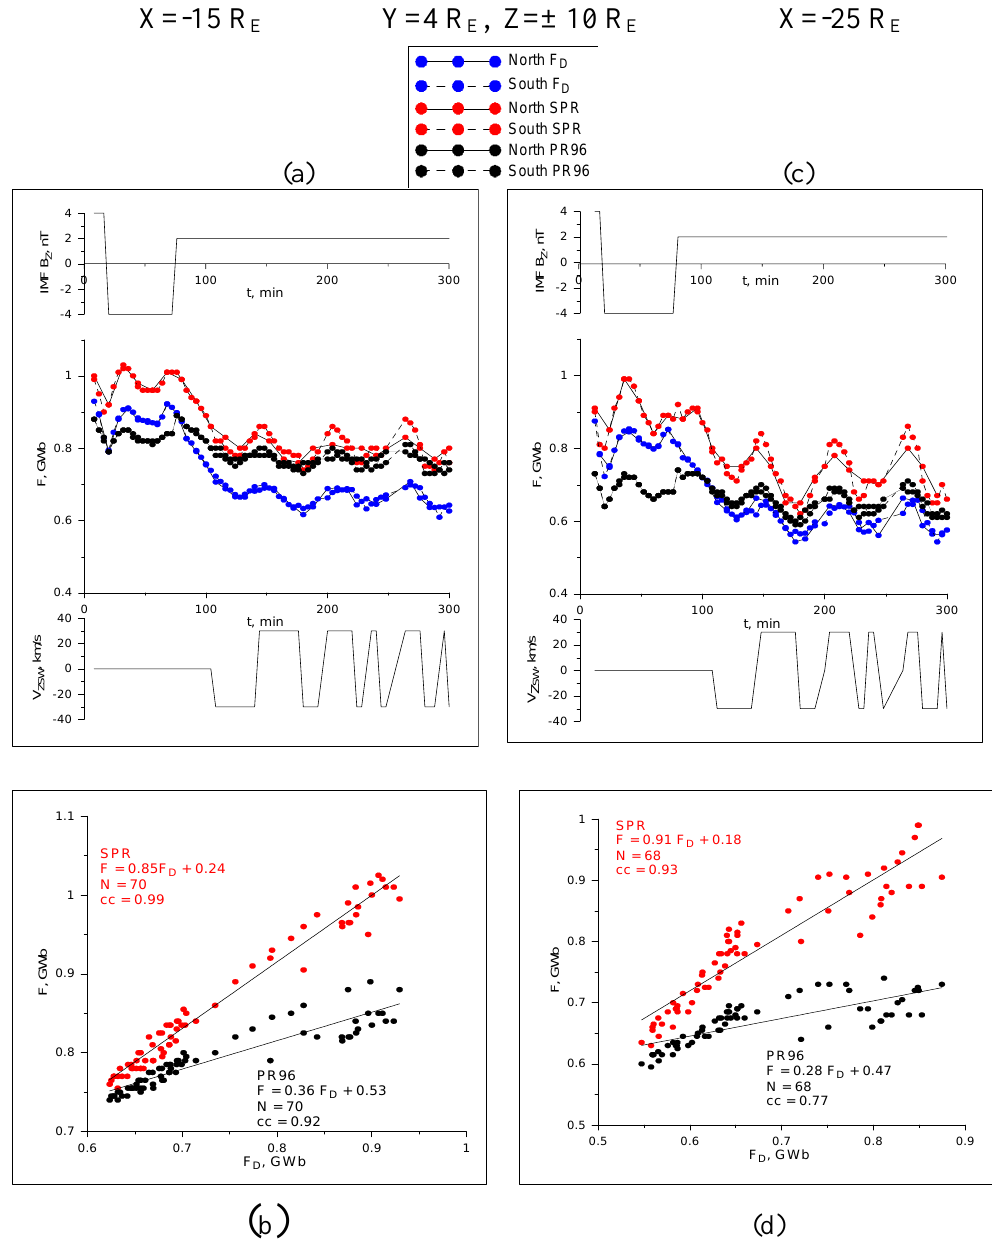
Fig. 3. Top: Magnetic flux values, calculated by different methods at X = − 15 R E (a) and X = − 25 R E (c) for “observational points” in the tail lobes ( Z =± 10 R E ) . Solar wind B Z and V Z variations, shifted to the observational point, are also shown. Bottom: comparison of flux values, calculated by different methods for X = − 15 R E (b) and X = − 25 R E (d) .